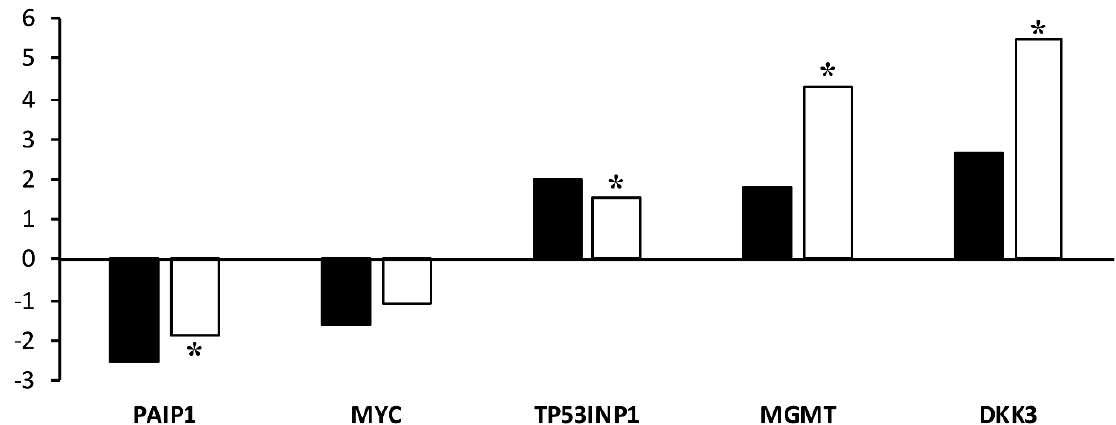
Figure 5. Validation of microarray results by RT-qPCR. The Y-axis represents the fold change between the vitrified and control blastocysts. * Asterisks indicate significant differences between the vitrified and control groups, as determined by RT-qPCR analysis.